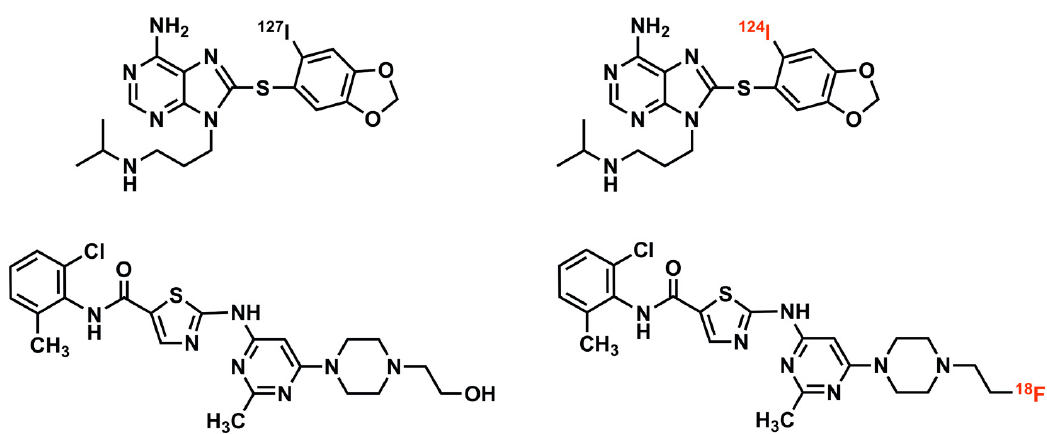
Figure 1. Drug tracer imaging of small molecule therapeutic compounds employs isotopologues or radiolabeled analogues. For example, I-124 PU-H71 (top right) is an isotopologue of the epichaperome inhibitor therapeutic compound, PU-H71 (top left), identical in molecular structure, differing only in the isotopic form of a constituent atom (stable iodine-127 versus the positron-emitting iodine-124) [7,8]. F-18 SKI-249380 (bottom right) is a radiolabeled analogue of the tyrosine kinase inhibitor therapeutic compound, dasatinib (bottom left). The positron-emitting fluorine-18 atom, in F-18 SKI-249380, replaces a hydroxyl group found in dasatinib; this substitution has minimal pharmacologic effect, enabling F-18 SKI-249380 to be an effective drug tracer of dasatinib [9,10]. Developing new cancer drugs is a slow, expensive process that usually fails [11–13]. The need for new target- and drug-specific pharmacometrics is recurrent and fundamental to the clinical development of new cancer pharmacotherapeutics [14,15]. A growing pharmacopoeia of investigational drug tracers have been clinically tested, with various degrees of qualification [1] as imaging biomarkers (Table 1). Table 1. Selected examples of isotopologues and radiolabeled analogues developed as positron emission tomography (PET) imaging tracers of specific therapeutic small molecule cancer drugs, from published peer-reviewed research reports (abstracts available at www.pubmed.gov). Published literature includes numerous other small molecule radiotracers that have been tested as radiologic biomarkers of important oncotherapeutic targets or as companion diagnostics for radionuclide therapy.